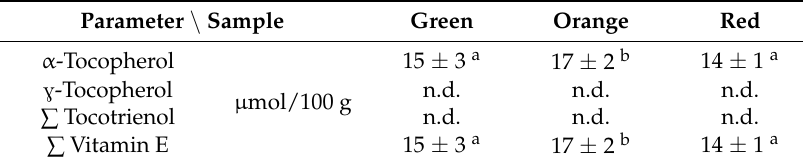
Table 2. Tocopherol and tocotrienol concentrations ( µ mol/100 g) in rosehips of R. rugosa at different ripening degrees. Parameter \ Sample Green